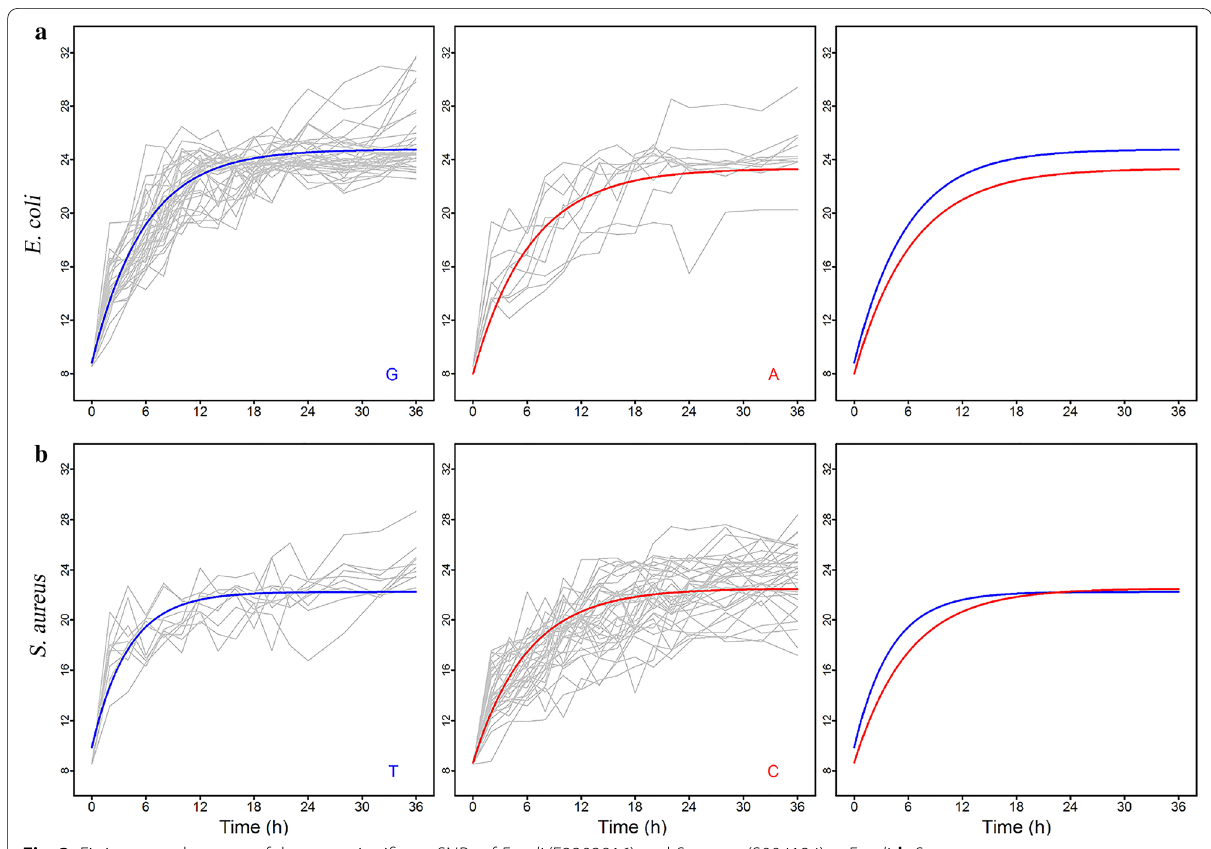
Fig. 3 Fitting growth curves of the most significant SNPs of E. coli (E3393816) and S. aureus (S994124). a E. coli ; b S.